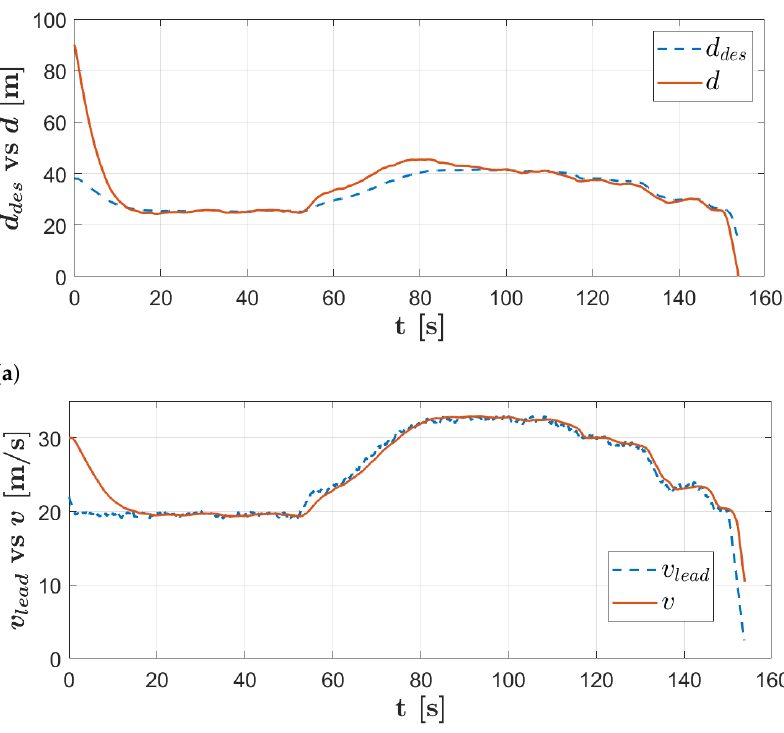
Figure 9. Driving Functionalities without on-board road-grip estimate: vehicle-following and hard emergency braking. ( a ) Time-history of the current distance gap, d , and of the desired one, d des . ( b ) Time-history of the ego velocity v and leader velocity v lead